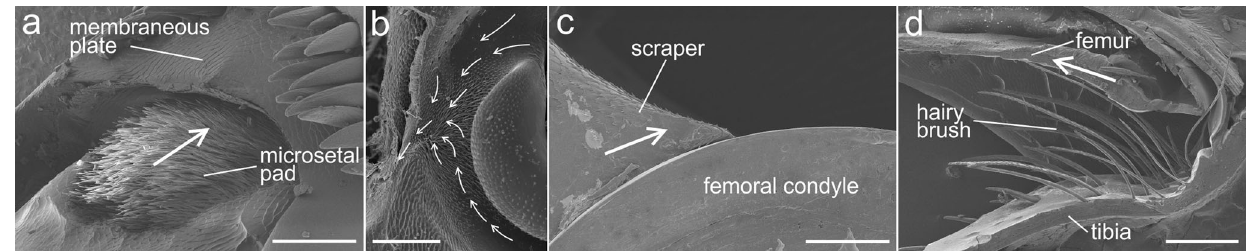
Fig. 5 Auto-cleaning structures in the femoro-tibial joint of Pachnoda marginata . a Microsetal pad/membraneous plate; b internal cavity; c